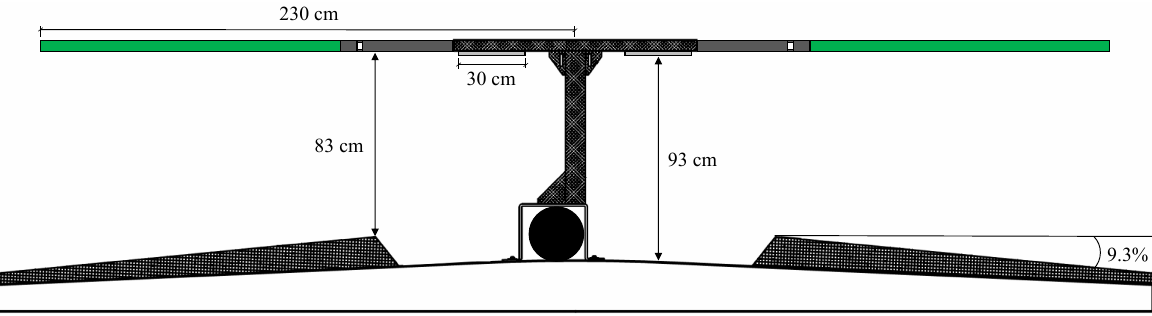
Figure 1. Sideview of the stall partitions containing light-emitting diode (LED) lights. The stall partitions were a novel design further modified from a previous experiment. LED lights were placed in an opening of the metal stall partitioning and secured using 3D-printed plastic clips. Foam (not visible) was placed inside the partitions between the LED light and metal to reduce the upward movement of the light. Wiring was contained in a 20-cm-diameter high-density polyethylene (HDPE) supply pipe (black circle in the figure) that ran along the centre of the stalls. Facility lights were on from 0400 to 2000 h and were fluorescent with a correlated colour temperature (CCT) of 4100 Kelvin (K; F32T8/TL841 PLUS ALTO HV, Philips Lighting, Amsterdam, Netherlands). Illumination in the experimental pen was 271 ± 29 (mean ± SD) lux (lx), recorded at 0500 h (before sunrise) on 2 separate days. In addition, 12 measurements were taken at standing cow eye height throughout the pen, and 28 measurements were taken at the approximate height of cows’ eyes standing and lying in the stalls (described in Table 1). The lux and wavelength of the facility lighting and treatment light- ing were measured using a spectrometer (LI-180 Spectrometer, LI-COR Biosciences, Lin- coln, NE, USA). Natural daylight entered the facility through side curtain walls along the feed alley. At the beginning of the experiment, the sunrise was at 0721 h and sunset at